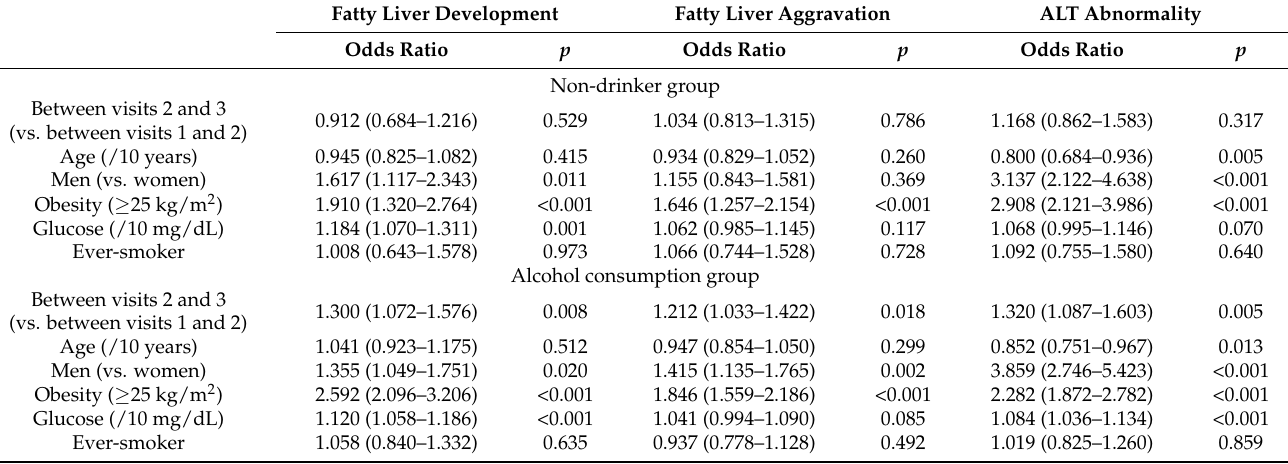
Table 3. Multivariate logistic regression models for fatty liver change in the non-drinker and alcohol consumption